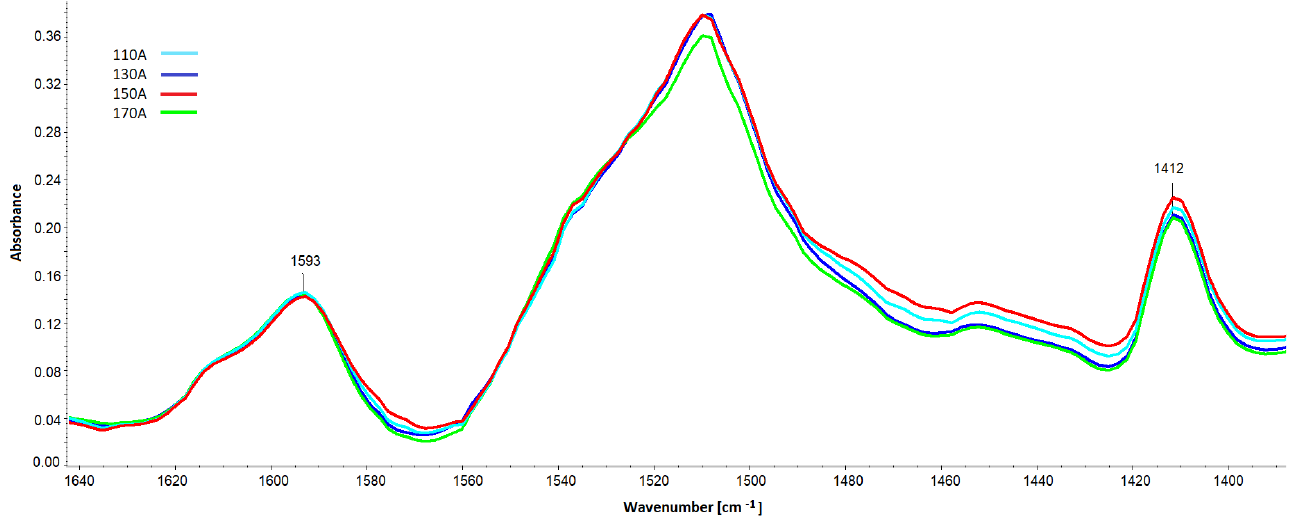
Figure 16. Spectral fragment with the band of polyisocyanurate PIR groups at 1412 cm −1 and the band serving to scale from the C-C bonds in the aromatic grouping (1593 cm −1 ).